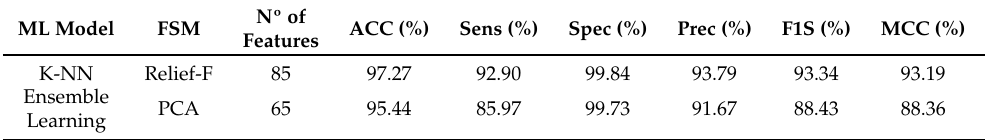
Table 9. Hold-out test results for the Ensemble Learning with the first 65 features ranked by the PCA and for the K-NN classifier with the first 85 features ranked by the Relief-f.